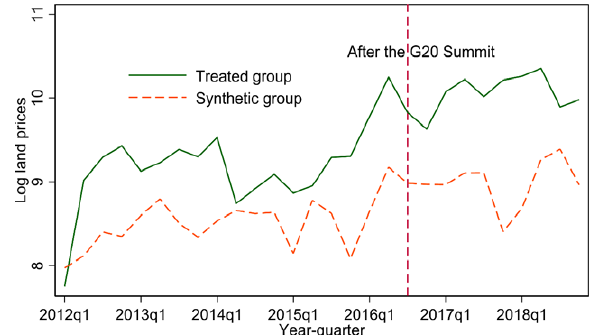
Figure 3. Result of synthetic control method